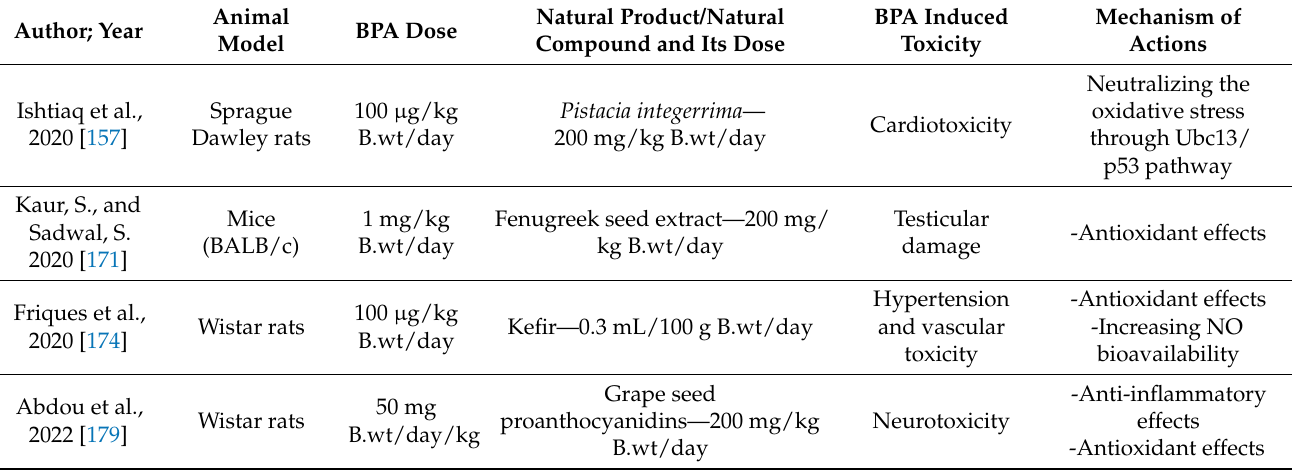
Table 1. Summary of experimental studies evaluating the ameliorative potential of natural products and natural compounds against BPA exposure-induced